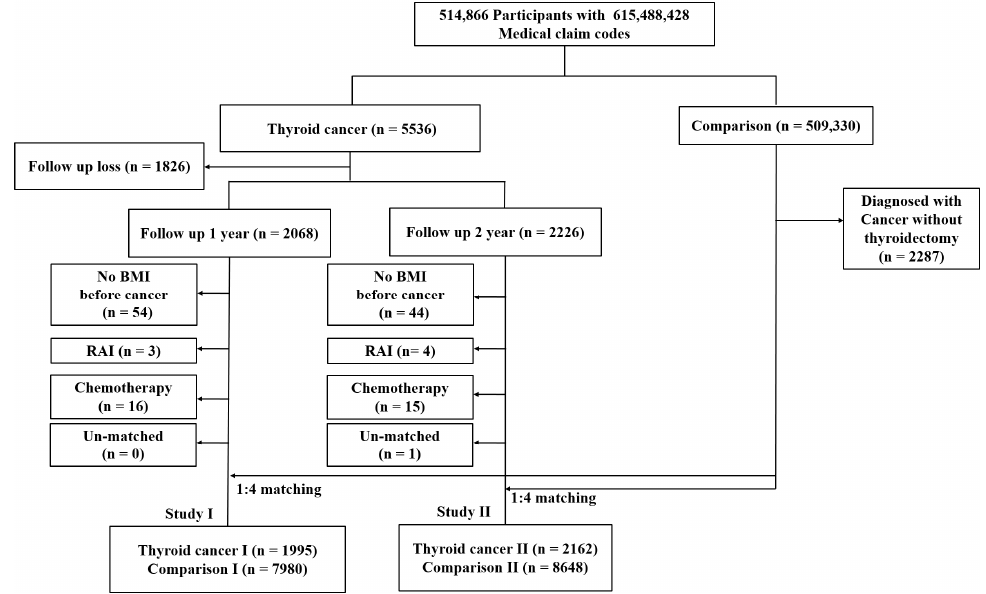
Figure 1. A schematic illustration of the participant selection process that was used in the present study. Of a total of 514,866 participants, 5536 thyroid cancer participants and 509,330 comparison participants were included in this study. Of a total of 514,866 participants, 1995 thyroid cancer I participants were 1:4 matched with 7980 comparison I participants for age, sex, income, region of residence and obesity. Of a total of 514,866 participants, 2162 thyroid cancer II participants were 1:4 matched with 8648 comparison II participants for age, sex, income, region of residence and obesity.